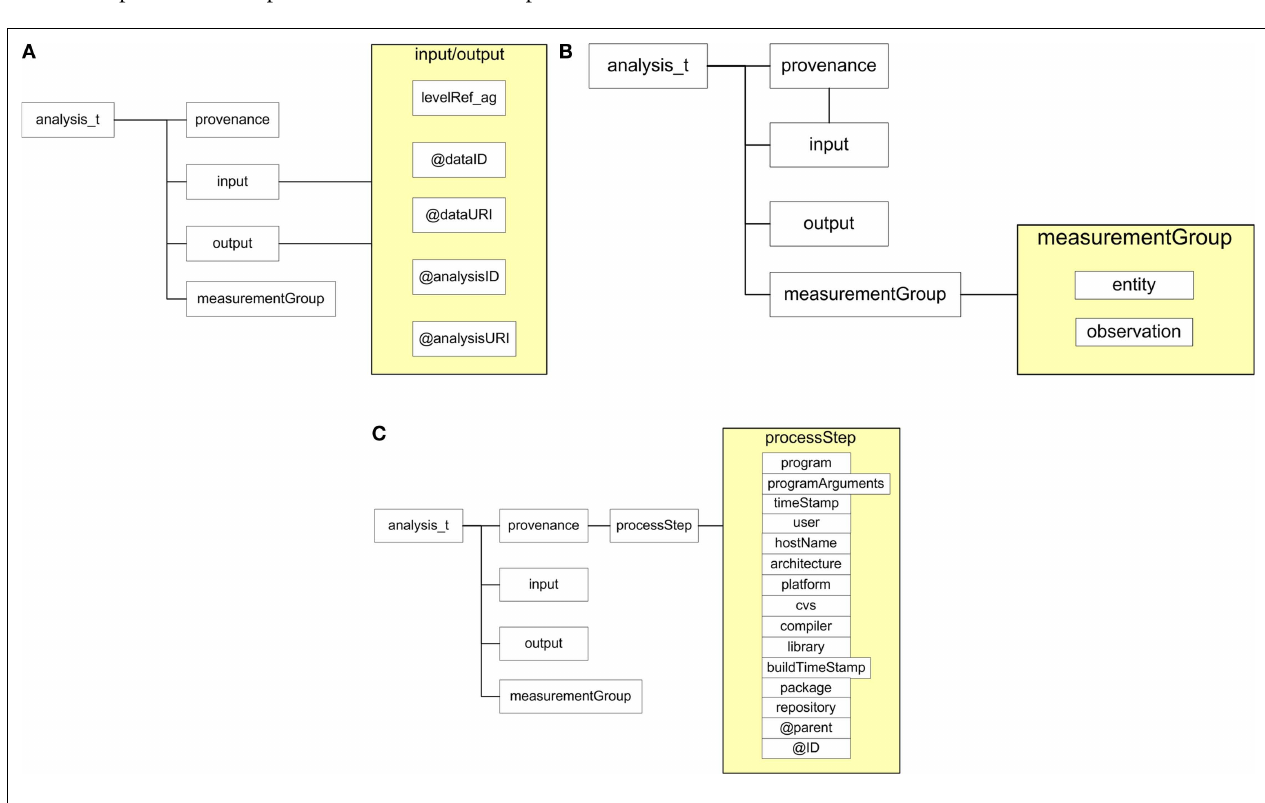
FIGURE 6 | < analysis_t > components of the XCEDE2 schema. The input/ output components (panel A ) used to reference input data and output derived data fi les and/or metadata. The measurement group component (panel B ) used